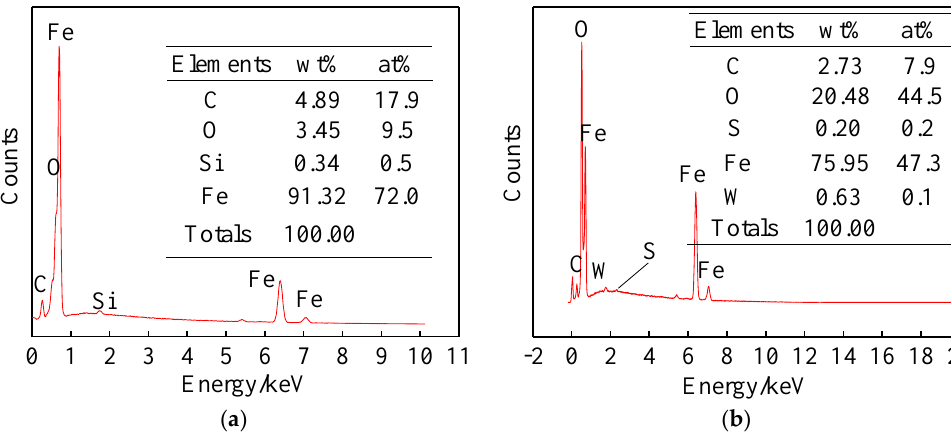
Figure 11. EDS chart on abrasion scars from ( a ) base oil, and ( b) 0.1 wt % WS 2 -CS lubricant.